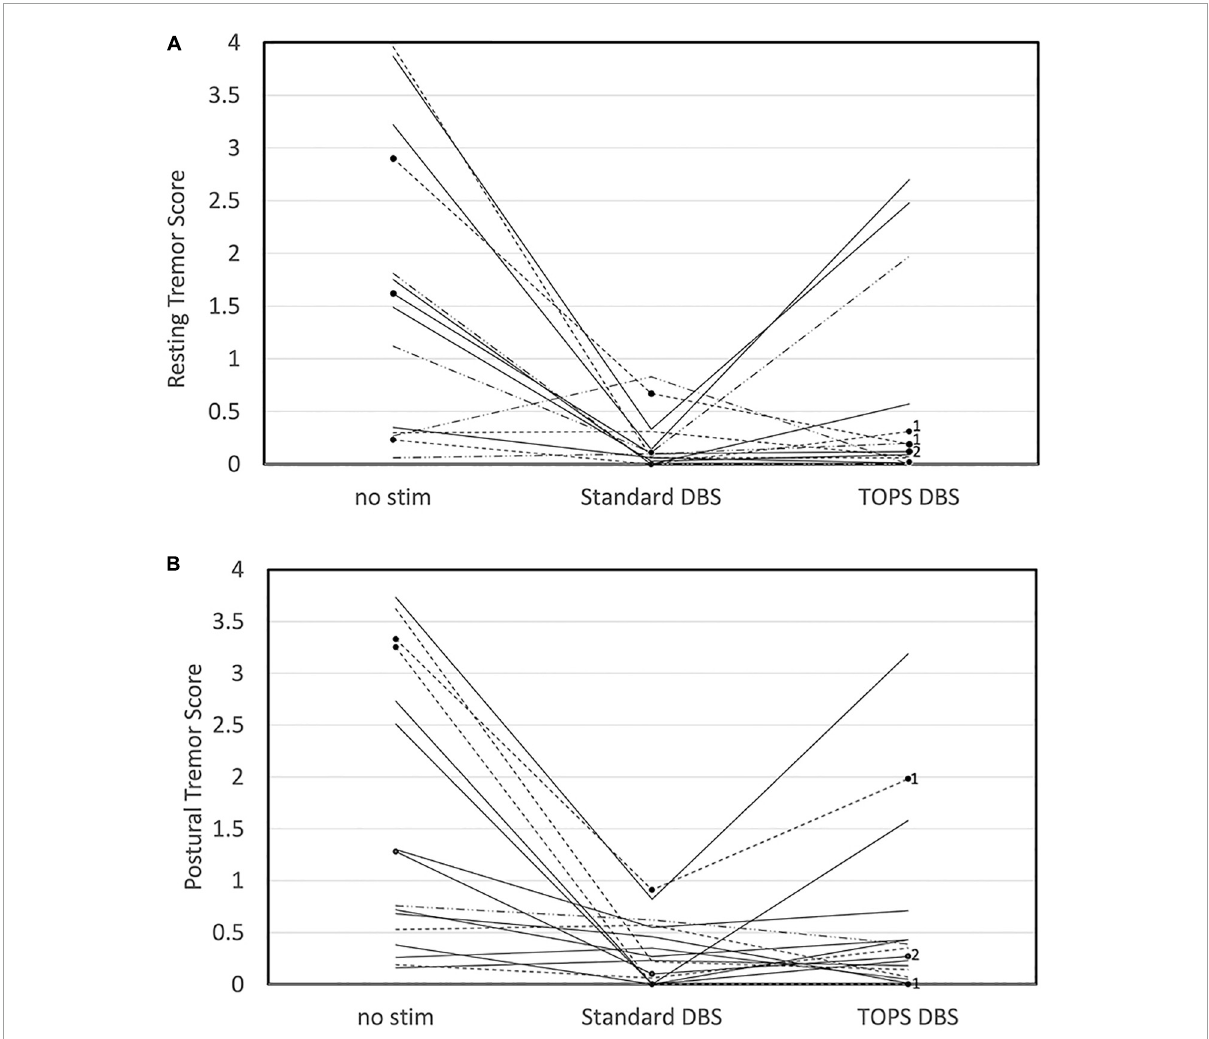
FIGURE2 Tremor, quantified using the Kinesia One system, in persons with PD and STN DBS while on their Parkinson’s medications was dependent on stimulation pattern. Resting (A) and Postural (B) tremor scores are shown for no stim, sDBS and the most effective TOPS pattern (TOPS1 or TOPS 2). Patterns were tested with each patient’s stimulation parameters clinically optimized for sDBS. Scores varied across stimulation patterns for resting tremor ( F = 9.64, p = 0.0007) and postural tremor ( F = 11.64, p = 0.0002). Dotted lines represent subjects in whom TOPS1 was the most effective TOPS. Solid lines represent subjects in whom TOPS2 was the most effective TOPS. In three subjects, only one TOPS pattern was assessed, and these are marked with black dots and labeled with the pattern tested (TOPS1 = 1 or TOPS2 =